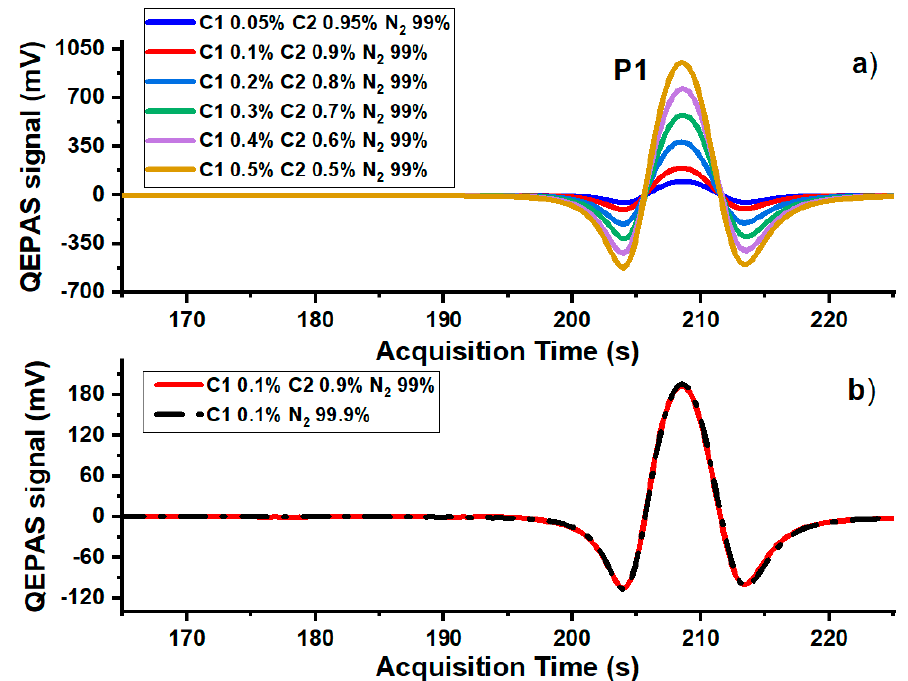
Figure 4. ( a ) P1 QEPAS signals measured in the LD1 emission range nearby P1 for six mixtures of C1, C2 and N 2 . ( b ) Comparison of LD1 0.1% methane QEPAS signals between mixtures containing 99.9% nitrogen, and 99% nitrogen and 0.9% ethane. Molecules 2020 , 25 , x FOR PEER REVIEW